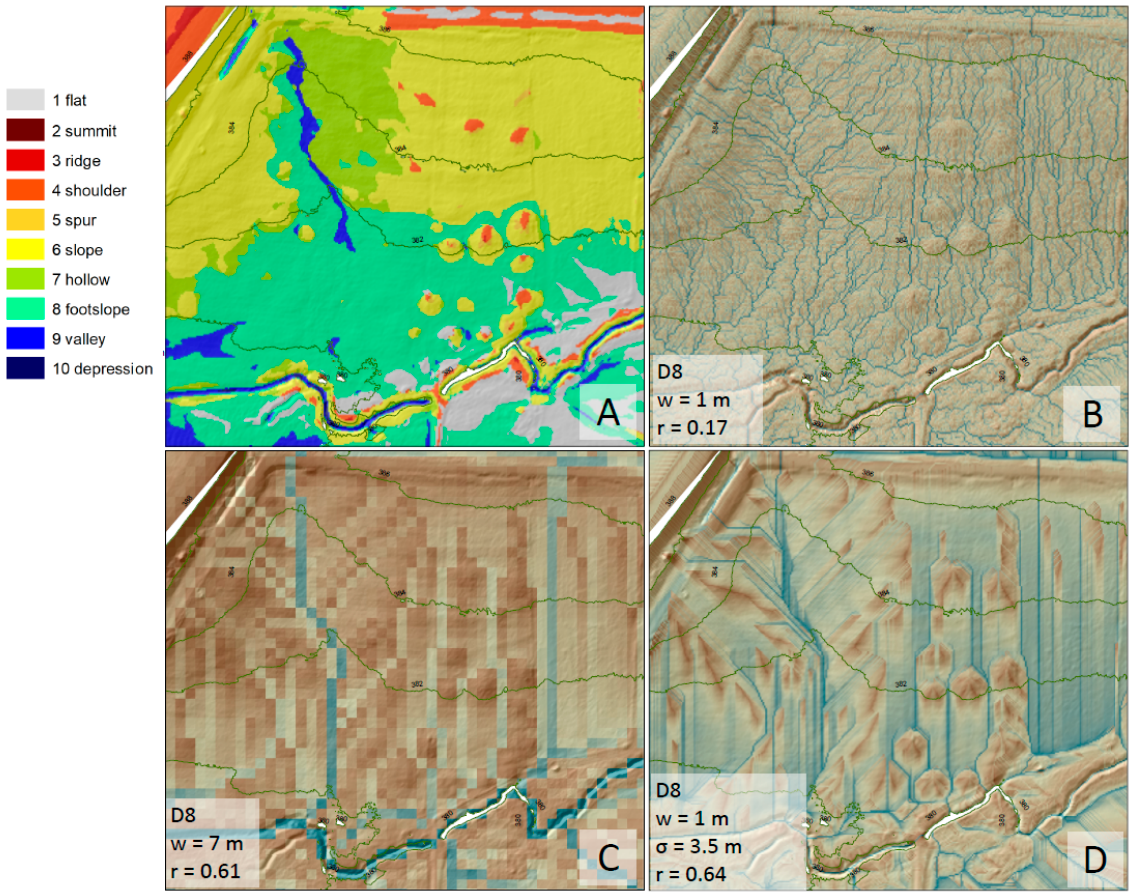
Figure 9. ( A ) Landform classification using GEOMORPHONS algorithm [52] and TWI. The output of the GEMORPHONS algorithm color coded to show landscape classes. ( B ) TWI calculated with the D8 algorithm at high resolution. ( C ) TWI calculated after resampling. ( D ) TWI calculated after filtering. Terms used: w = pixel resolution; r = Pearson correlation between soil moisture and TWI; σ = sigma of the Gaussian curve for Gaussian filtering. Higher visualizations of TWI in ( B – D ), are darker blue, but TWI is shown on a unique relative scale for each image.